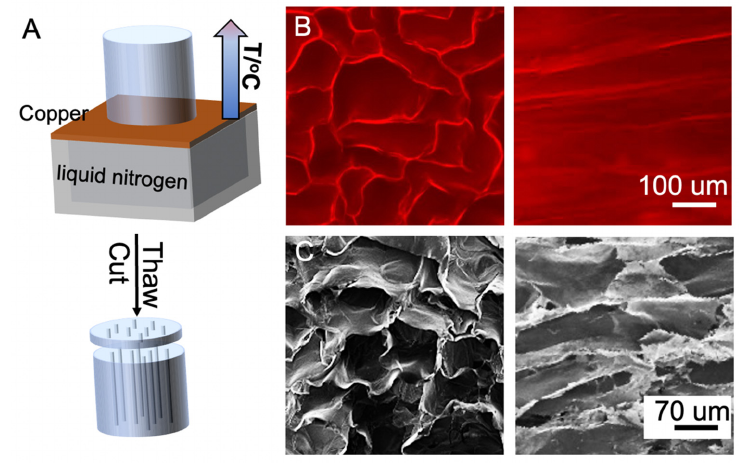
Figure 2. Generation of hydrogels with uniaxial microchannels: ( A ) Fluorescent images ( B ) of a hydrogel at transverse (left) and longitudinal (right) cross sections; SEM images ( C ) of the hydrogel at transverse (left) and longitudinal (right) cross sections after lyophilization.